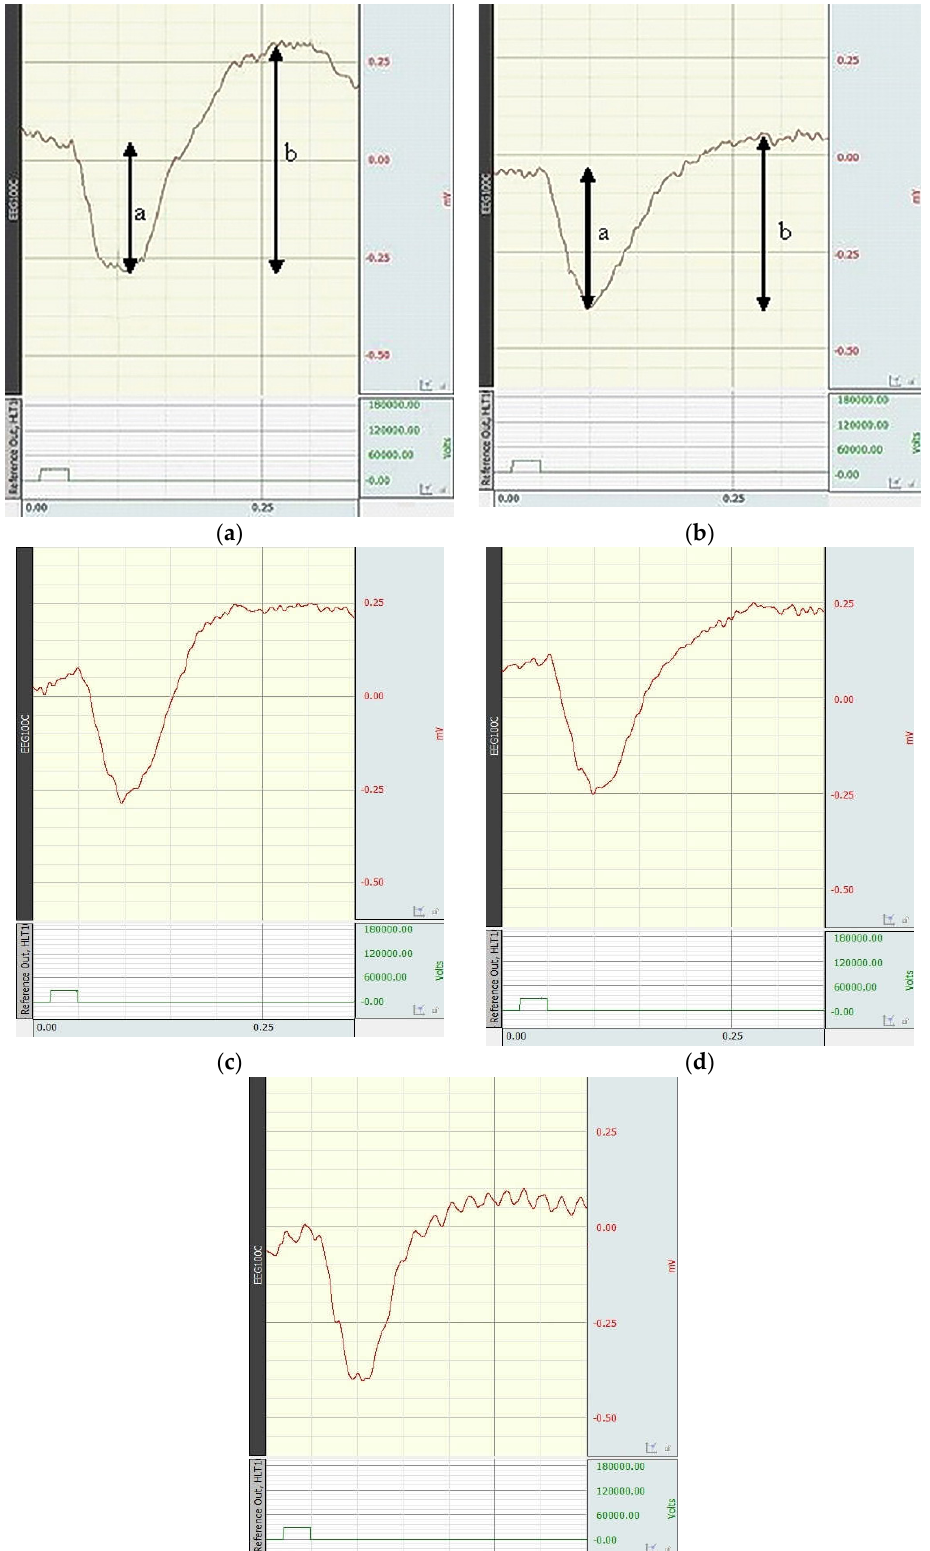
Figure 4. Electroretinograms of Wistar rats: ( a ) Control group; ( b ) with the simulated retinal ischemia–reperfusion; ( c ) with the administration of 2-ethyl-3-hydroxy-6-methylpyridine nicotinate; ( d ) with the administration of nicotinic acid; ( e ) with the administration of Emoxipine. Arrows show the amplitudes of the a-wave and